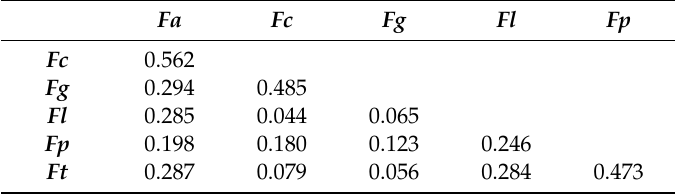
Table 4. Correlation coe ffi cients ( r ) of DNA amounts in wheat grain between F. graminearum ( Fg ), F. culmorum ( Fc ), F. avenaceum ( Fa ), F. poae ( Fp ), F. tricinctum ( Ft ) and F. langsethiae ( Fl ) summarized for all survey years (2013–2017) and cultivars (highly, moderately to highly and lowly to moderately susceptible) of the seven trial locations (three replications per location) in northern Germany. n = 315. Fa